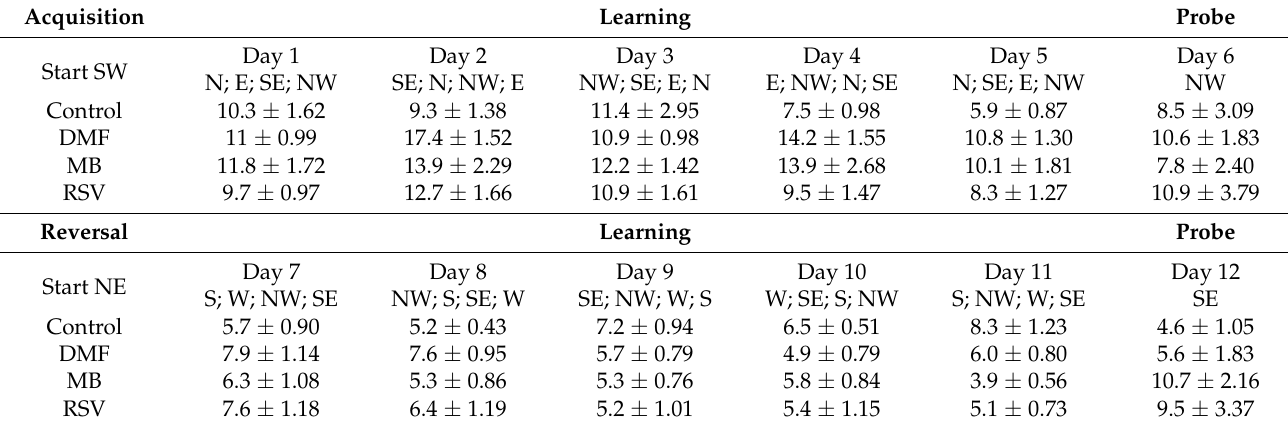
The results expressed as means ± SEM. Table 4. The time that mice spent in the quadrant with the platform. Table 4. The time that mice spent in the quadrant with the platform.